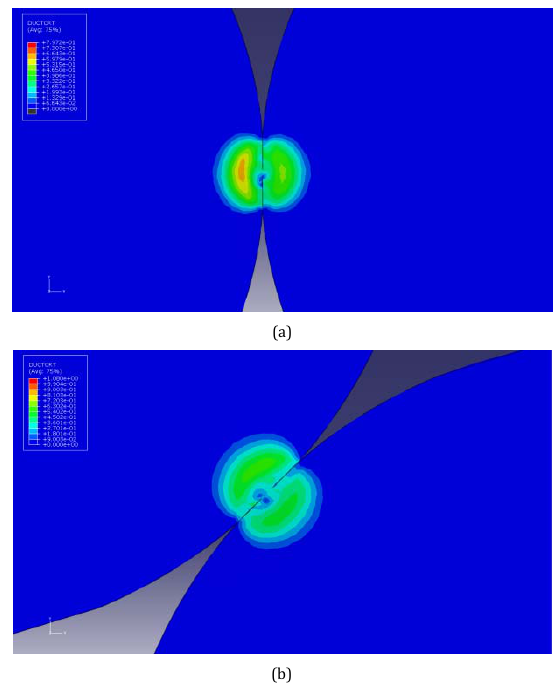
Figure 9. Damage contours at the contact points for (a) QS and (b) BCC models.